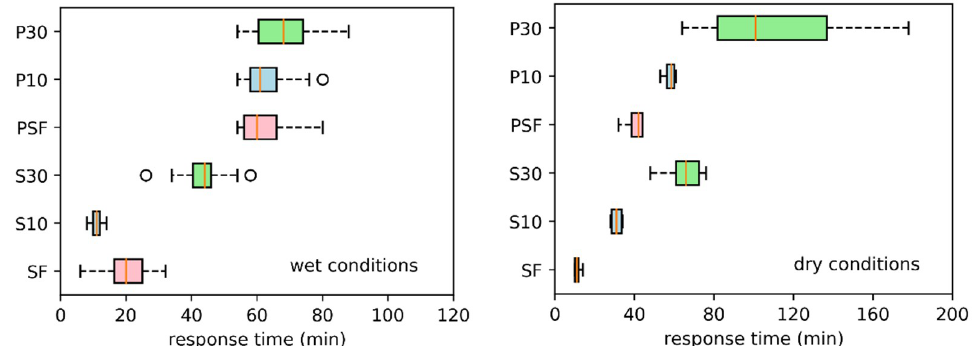
Figure 10. Response times in SM and SR for 30 of 32 events. The notches represent 50% confidence limit of the median values. Whiskers describe the highest and lowest nonoutlier data. Different variables are presented in different colors.